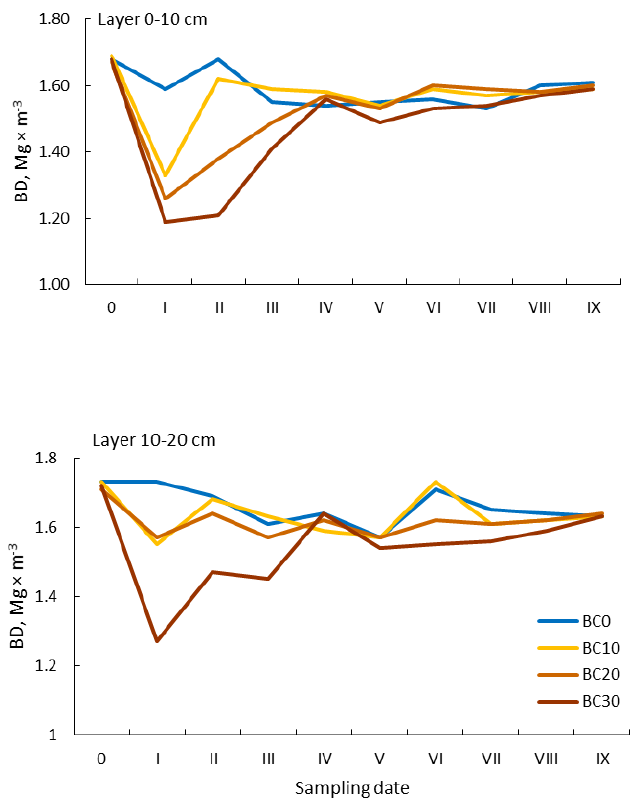
Figure 2. Bulk density (BD). Explanations as for Figure 1.